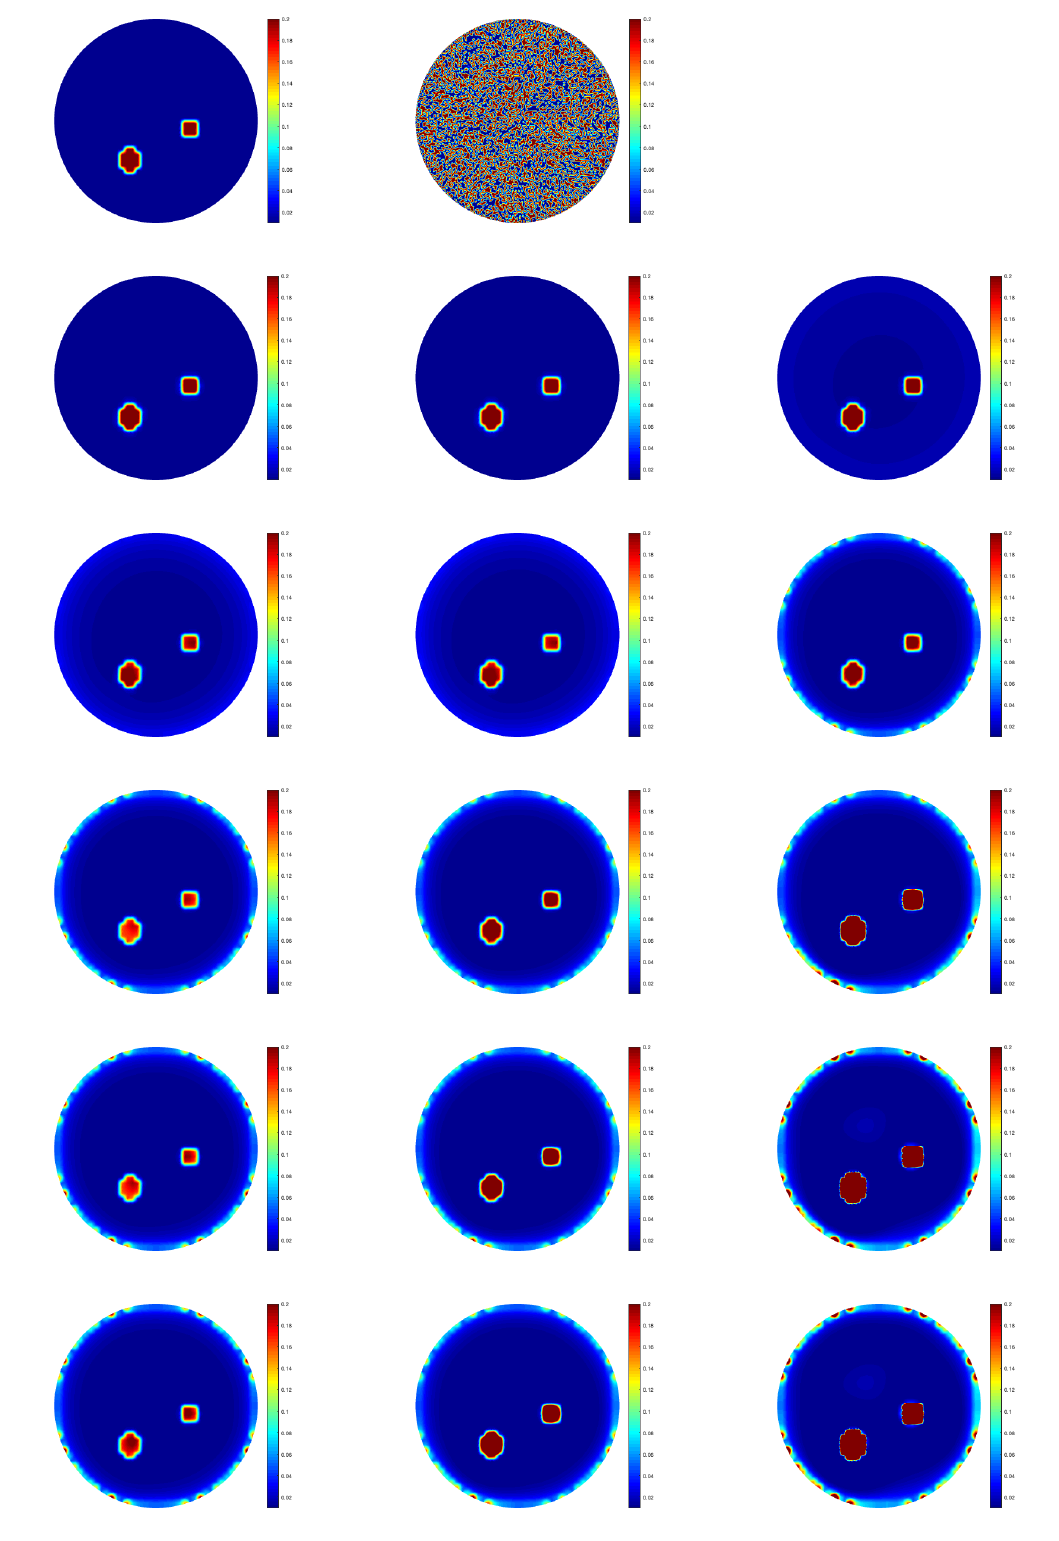
Figure 11. Reconstruction of the absorption coefficient µ a with two inclusions. The first row presents the true image ( left ) and initial guess image with an initial guess error δ = 0.2 ( right ). The second, third, fourth, and fifth rows present the reconstruction images using the learning rate β taking values equal to 0.001,0.01, 0.1, 0.2, and 0.3, respectively, using Nadam, Adam, and AmsGrad, from ( left to right